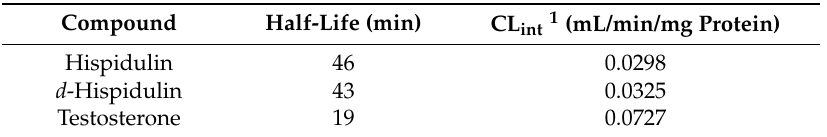
Table 4. Human liver microsome stability of hispidulin and d